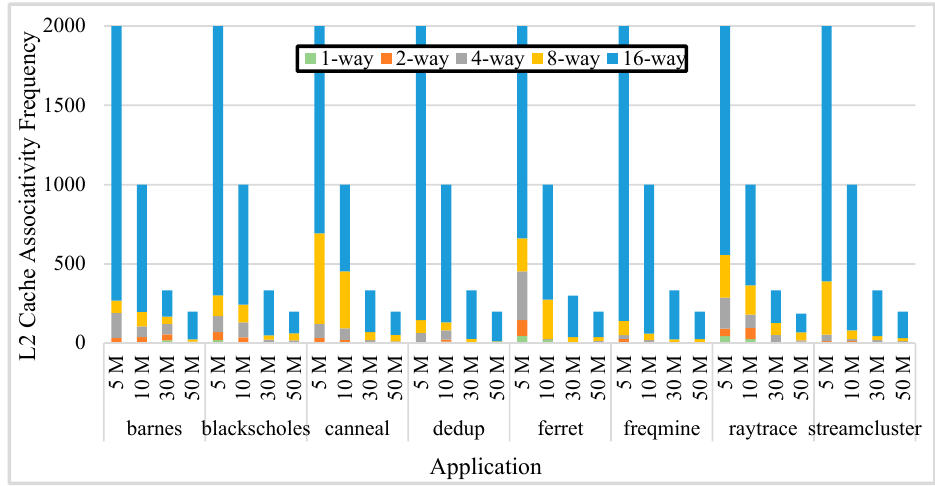
Figure 12. Associativity distribution.